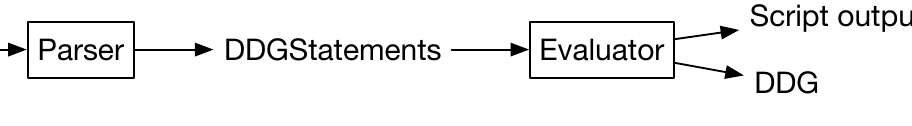
Figure 3. Architecture of